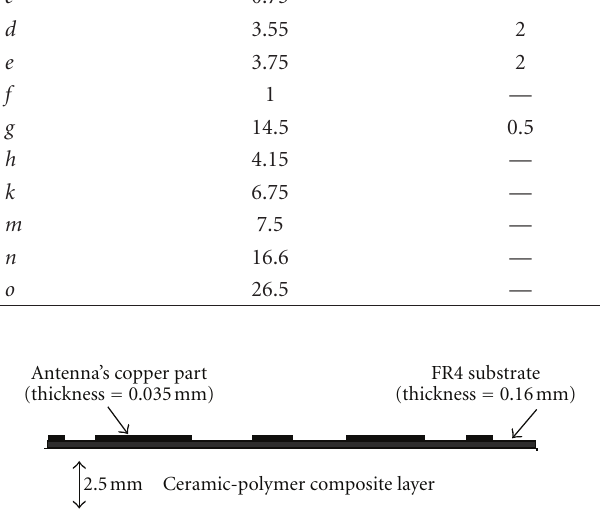
Figure 7: Side view of the tag antenna substrate.